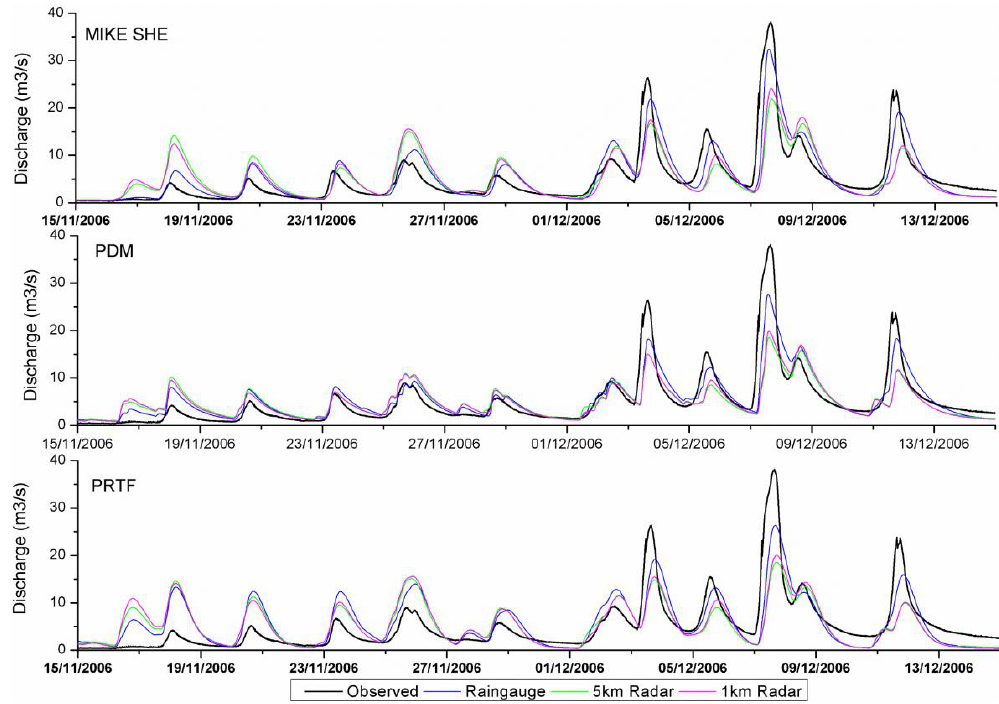
Fig. 8. Model simulations for evaluation period A using raingauge and radar rainfall.